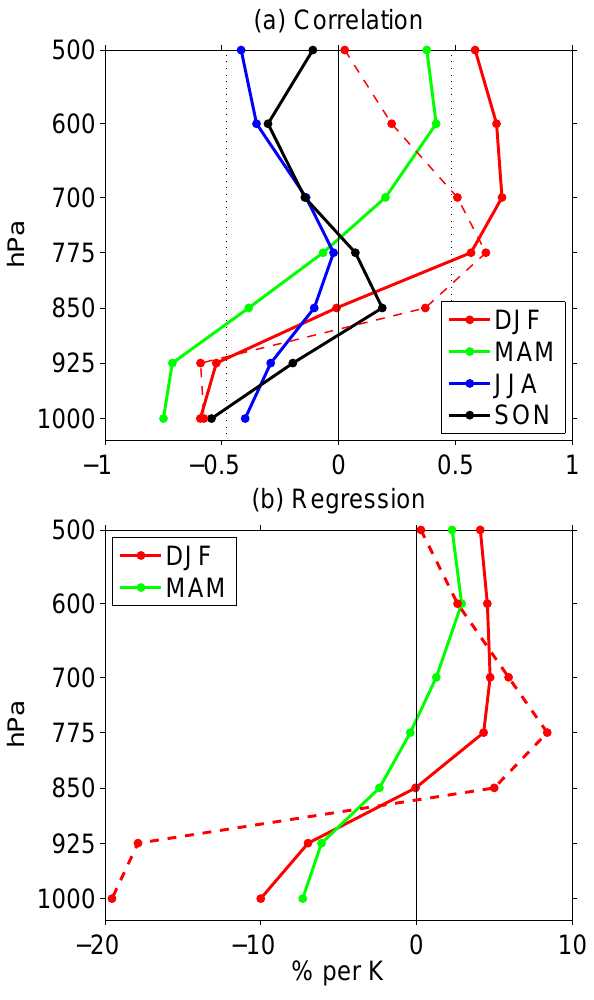
Fig. 6. Correlation coefficients (a) and regression coefficients (b) between seasonal mean, area-averaged (refer to the box of Fig. 1) adjusted low cloud amount and temperatures at each ver- tical level colored by seasons. Regression coefficients in only DJF and MAM are shown in (b) considering the correlation coefficients (a) are only significant through the column in those two seasons. The dotted lines in (a) denote the 95% significance level using the Student-t test for interannual cases. The red dashed line denotes the daily analog for DJF of the year 2000.